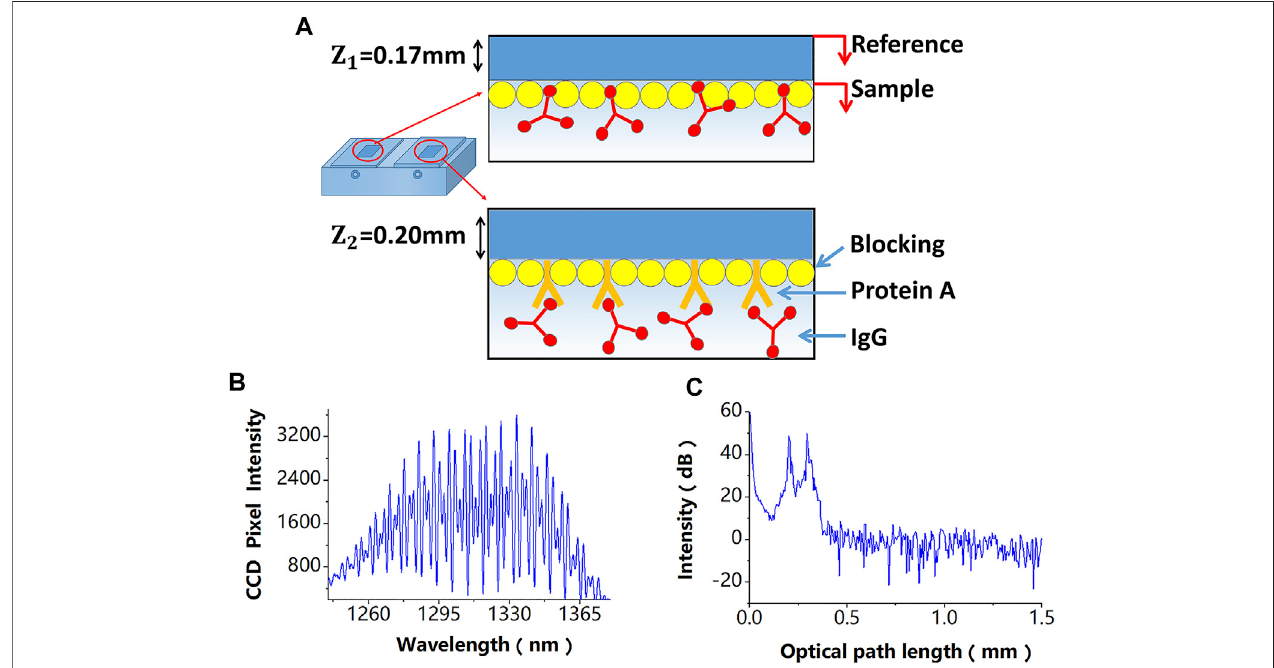
FIGURE 2 | (A) A differential-path modi fi cation method of sensing chips, the difference of these modi fi cation processes is that the referential path does not modify the probe molecule. (B) Superimposed interferometric spectra obtained by the SD-PSI. (C) Signal peaks corresponding to different OPDs obtained after performing the fast Fourier transform algorithm on the two superimposed interferometric spectra.